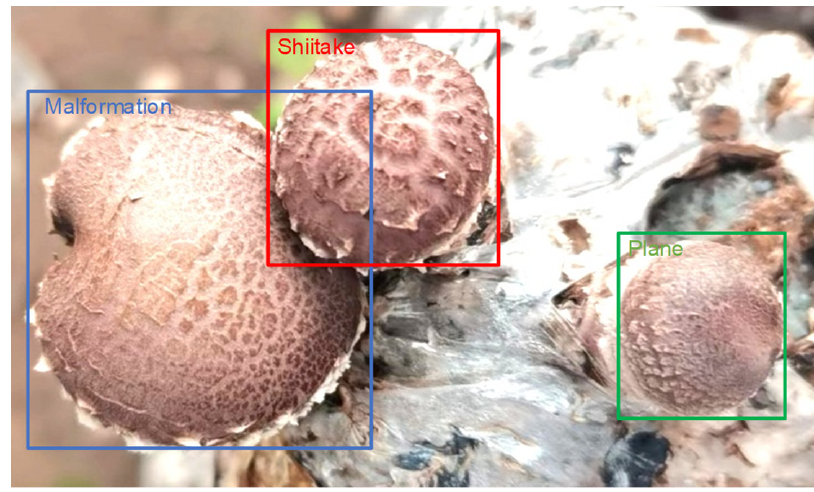
Figure 2. Example labels for various types of fresh shiitake mushrooms.